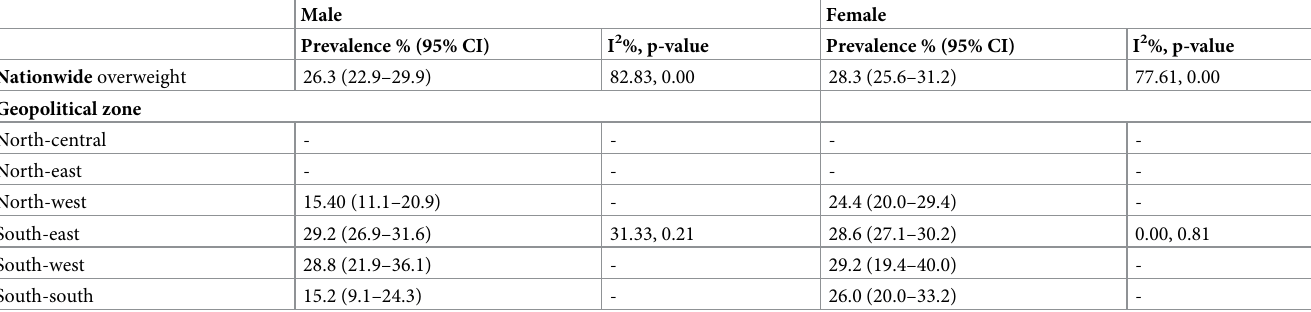
Table 4. Pooled estimates of the prevalence of overweight among men and women in Nigeria.